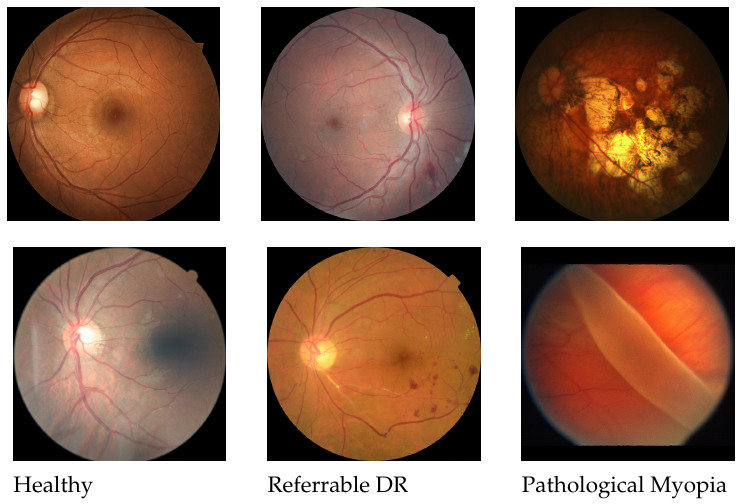
Figure 1. Fundus images of healthy ( left ); referable diabetic retinopathy ( middle ); and pathologic myopia ( right ). The referable fundus shows hemorrhage and white cotton-like patches (better view in the electronic version). Fundus with PM shows large patches of chorioretinal atrophy spread over the retinal fundus in many cases ( top-left ) or retina detachment may occur in severe cases ( bottom-right